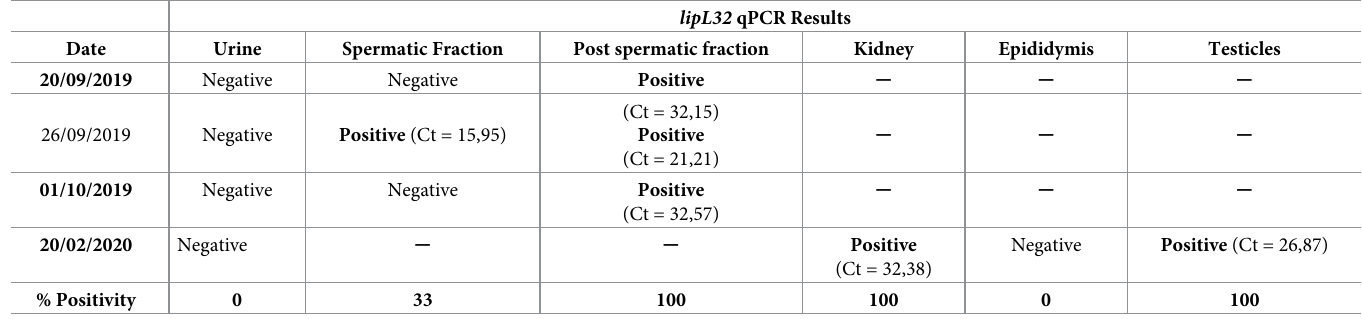
Table 1. Positivity of pathogenic Leptospira (amplification of lipL32 gene) in urine, semen, and tissue samples.